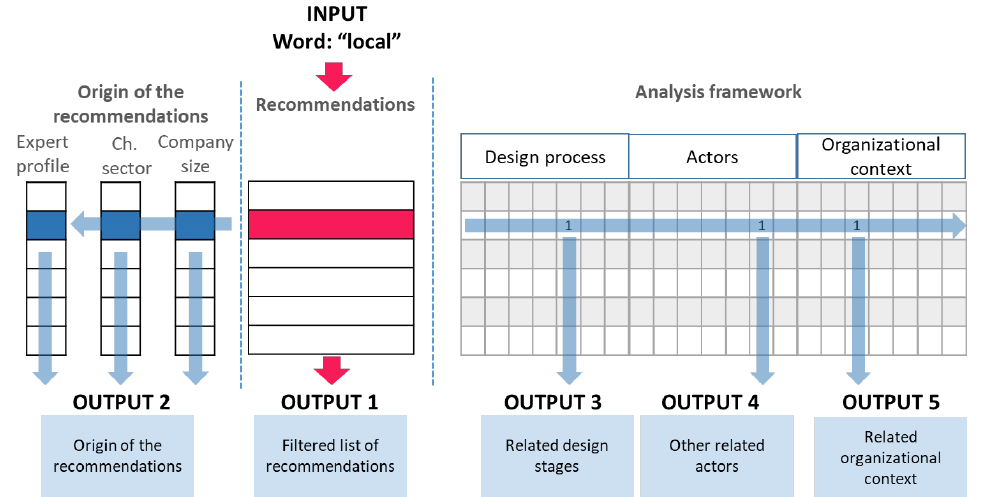
Figure 12. Example 2: f iltering the recommendations containing the word “local” . Figure 11. Example 2: filtering the recommendations containing the word “local”.